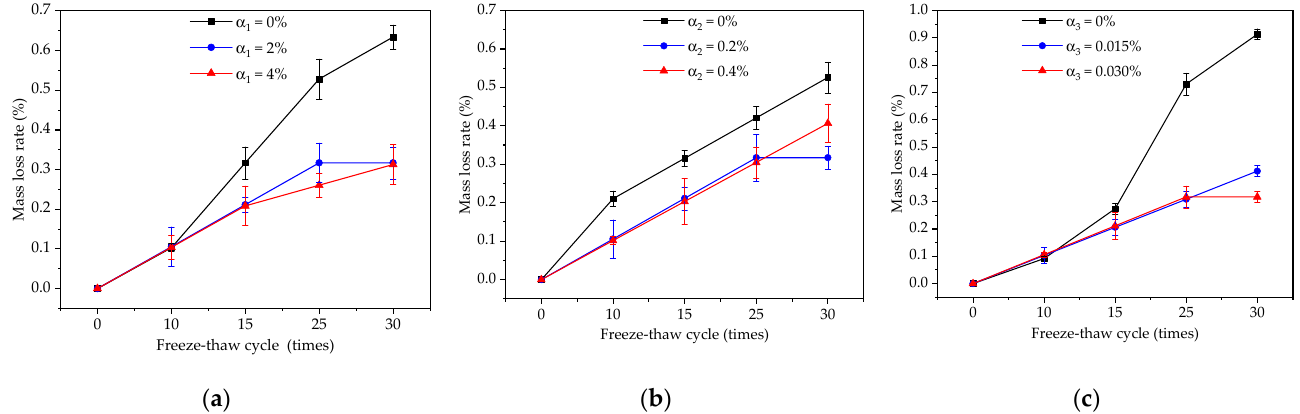
Figure 2. Influence of three factors on the mass-loss rate: ( a ) the factor of redispersible emulsion powder; ( b ) the factor of polypropylene fiber; ( c ) the factor of air-entraining agent.